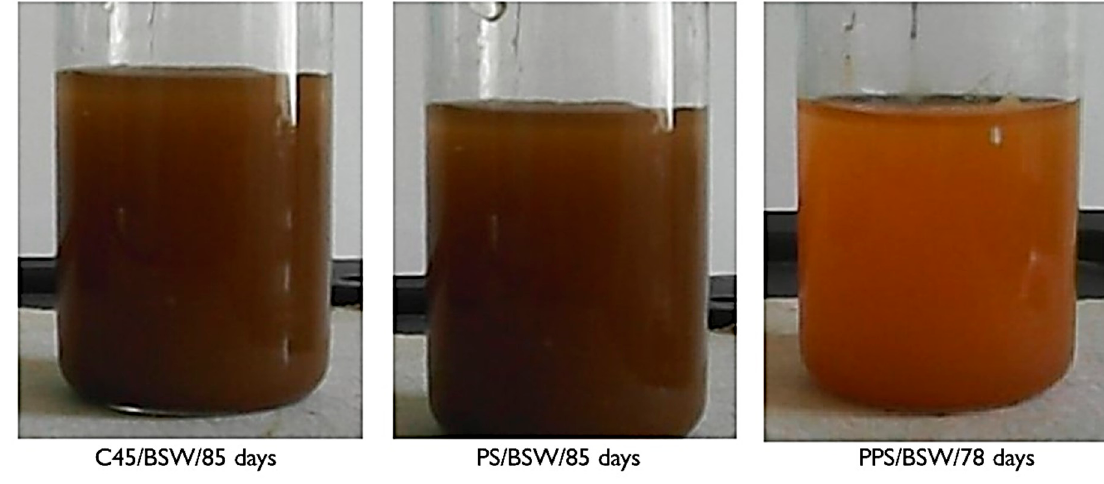
Figure 1. The corrosion environment appearance, after long immersion of alloys.